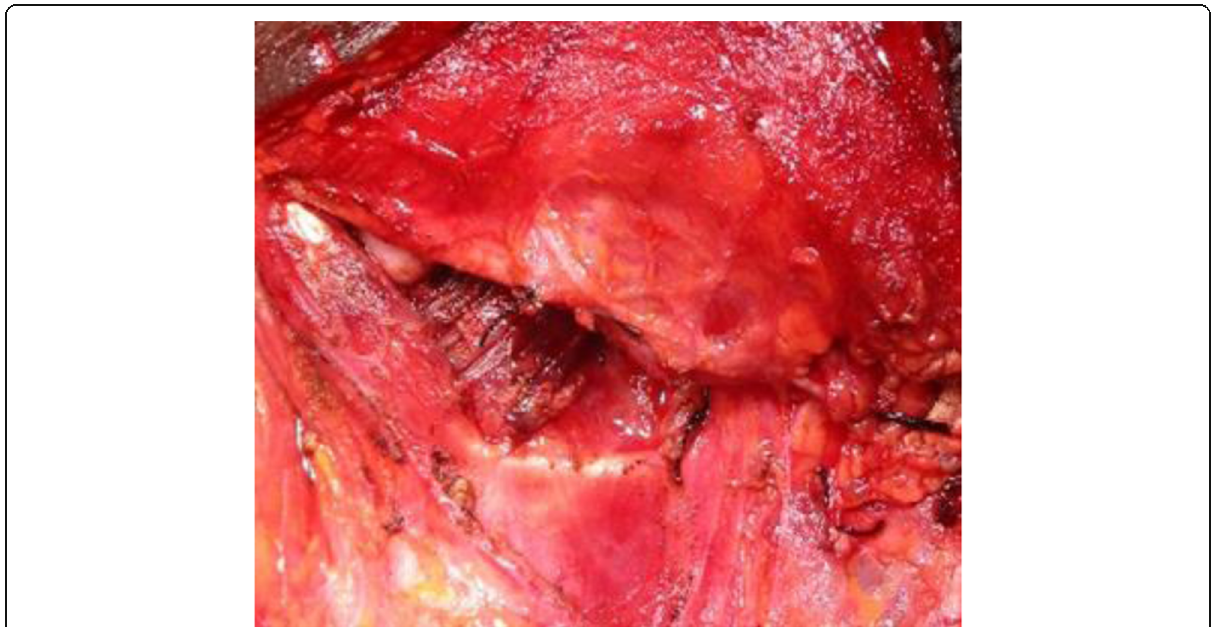
Fig. 23 A single branch of MMN travelling lateral to facial vein along the lower border of